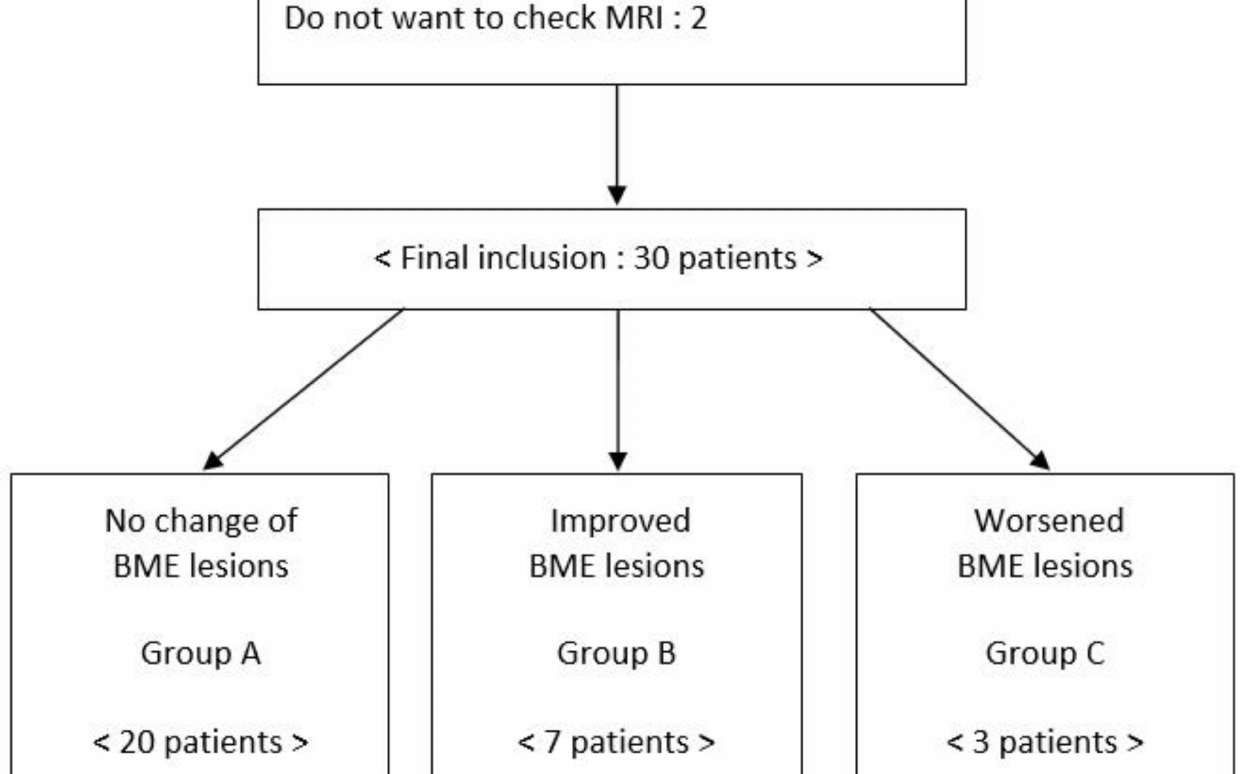
Figure 1. Flow chart of included